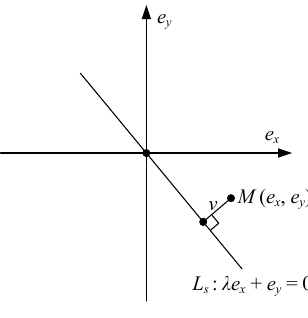
Figure 7. e x − e y plane of signed distance.